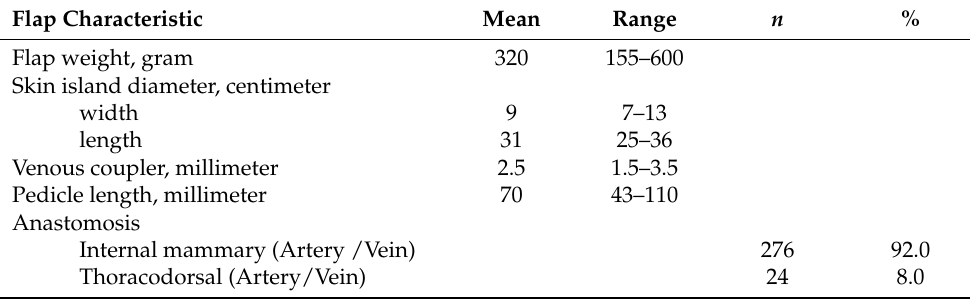
Table 3. Flap characteristics.